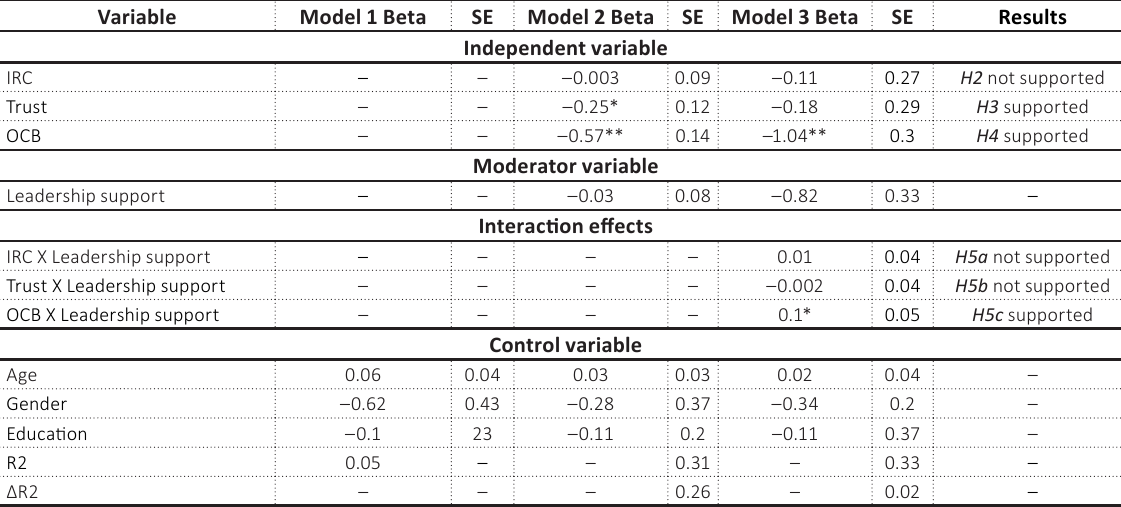
Table 3. Hierarchical linear